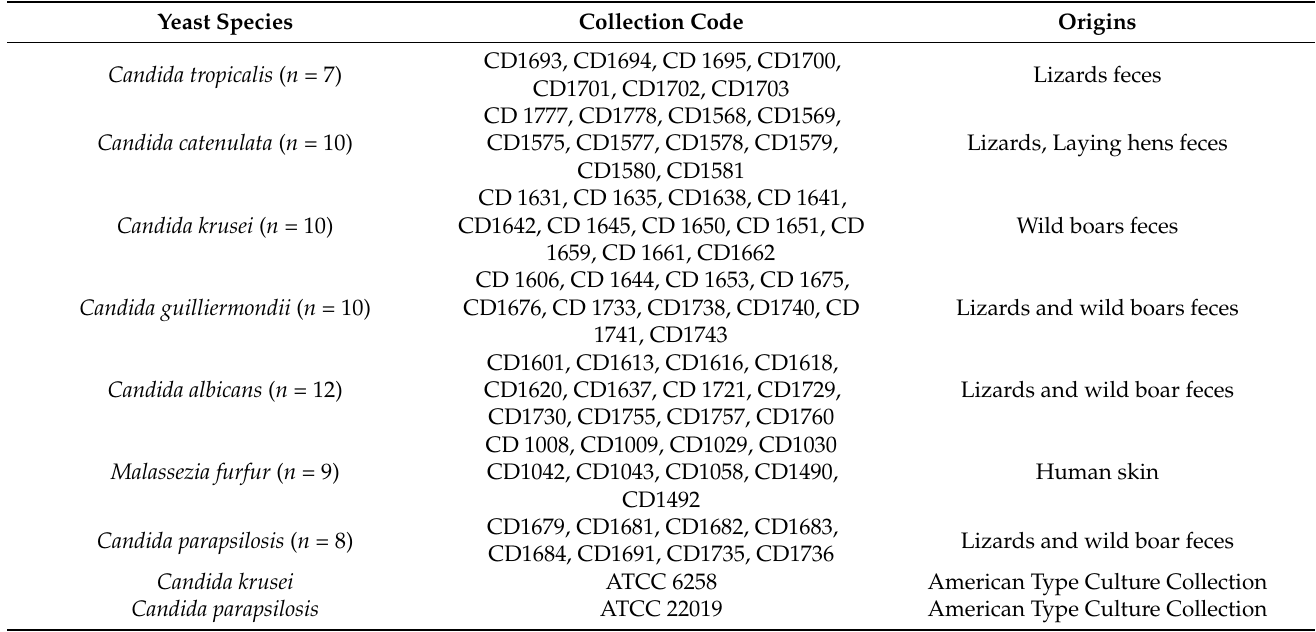
Table 5. Yeast strains used in this